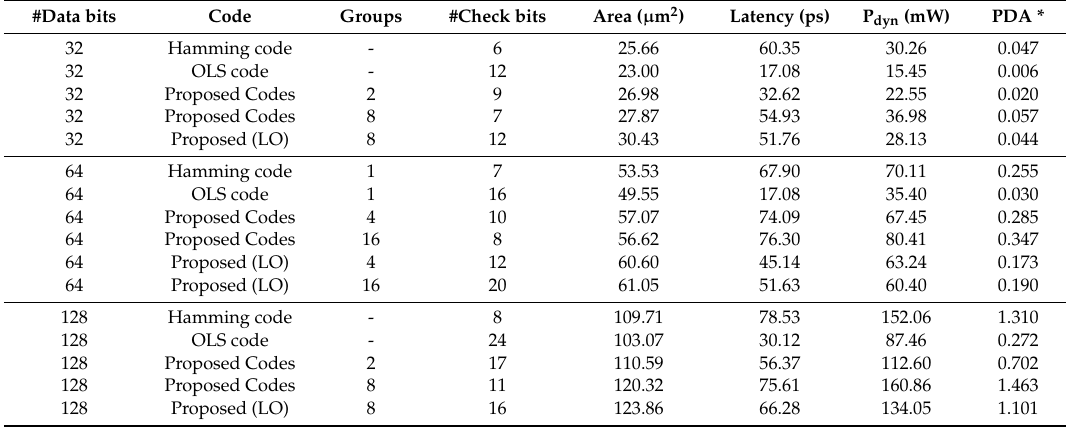
Table 1. Comparison of encoding circuit between the di ff erent